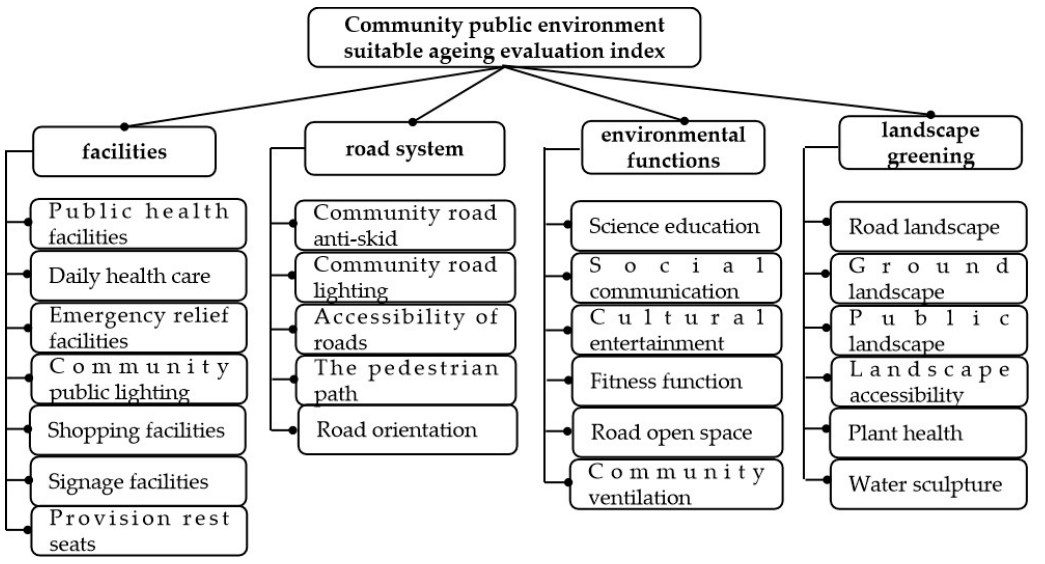
Table 6. Relative weight value of community public environment suitable aging evaluation